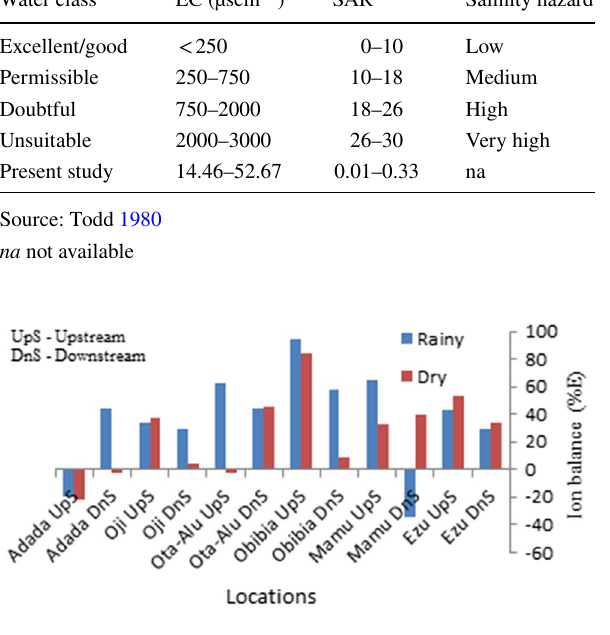
Fig. 9 Ionic balance histogram of River Mamu basin